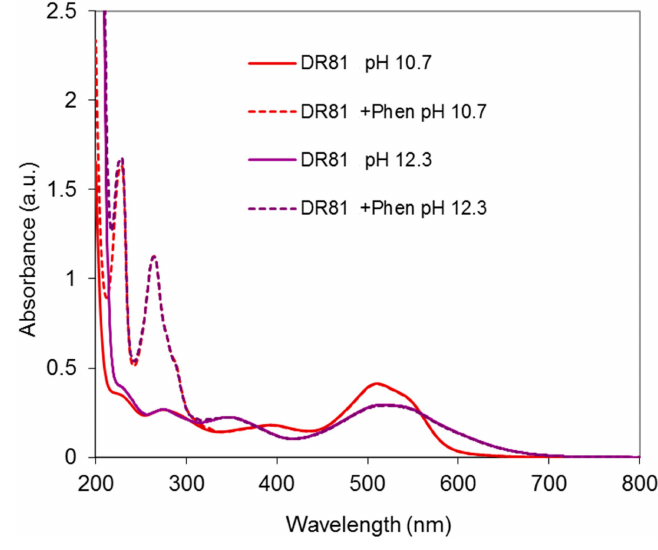
Figure 11. Absorbance spectra of the dye/phenanthroline system at pH 10.7 and 12.3, with DR81:Phen molar ratio = 1:3 and [DR81] = 10 µ M (equivalent to the amount of phenanthroline with DR81:Cu molar ratio = 1:1.5, Cu:Phen molar ratio = 1:2, and [Cu] = 15 µ M), compared to the dye alone at the same